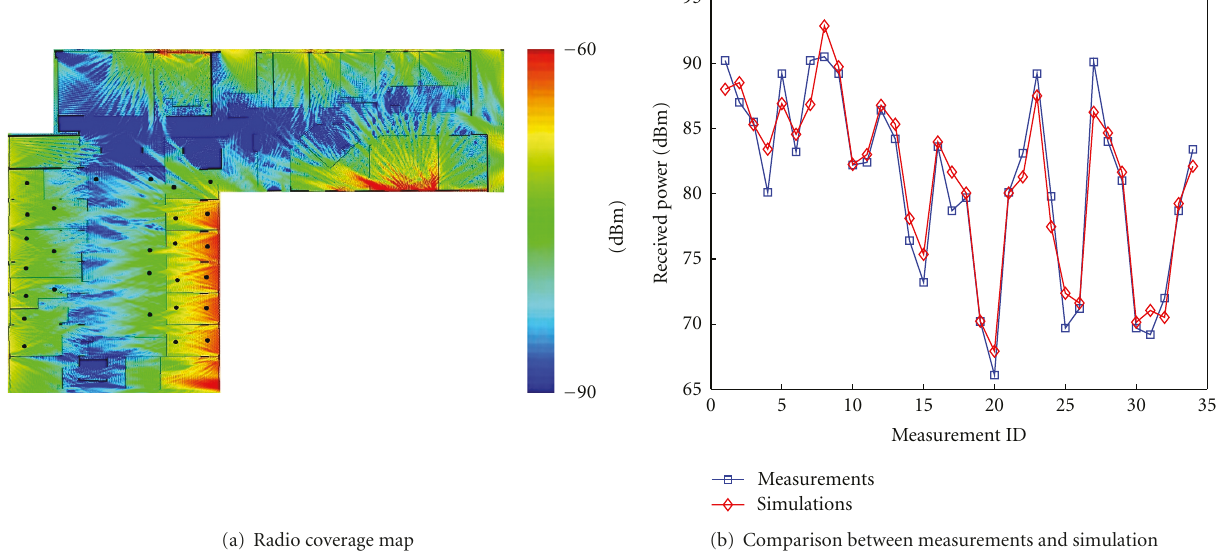
Figure 6: Outdoor to Indoor simulation results (Experiment 2).